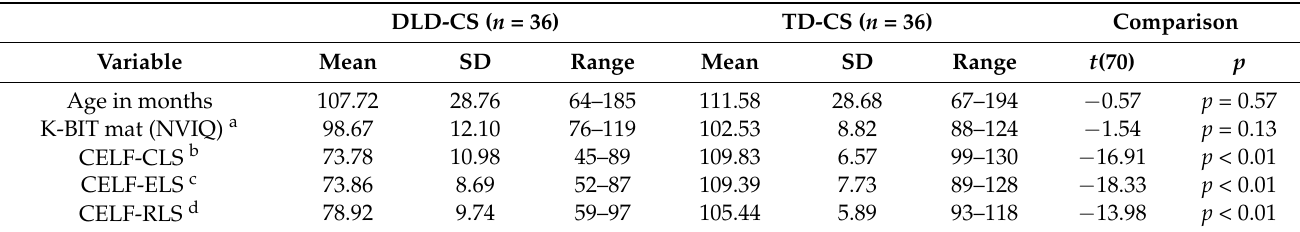
Table 1. Age and standardized scores for language and cognitive assessment measures for Catalan–Spanish children with developmental language disorder (DLD-CS) and typically developing (TD-CS) children. DLD-CS ( n = 36) TD-CS ( n = 36)